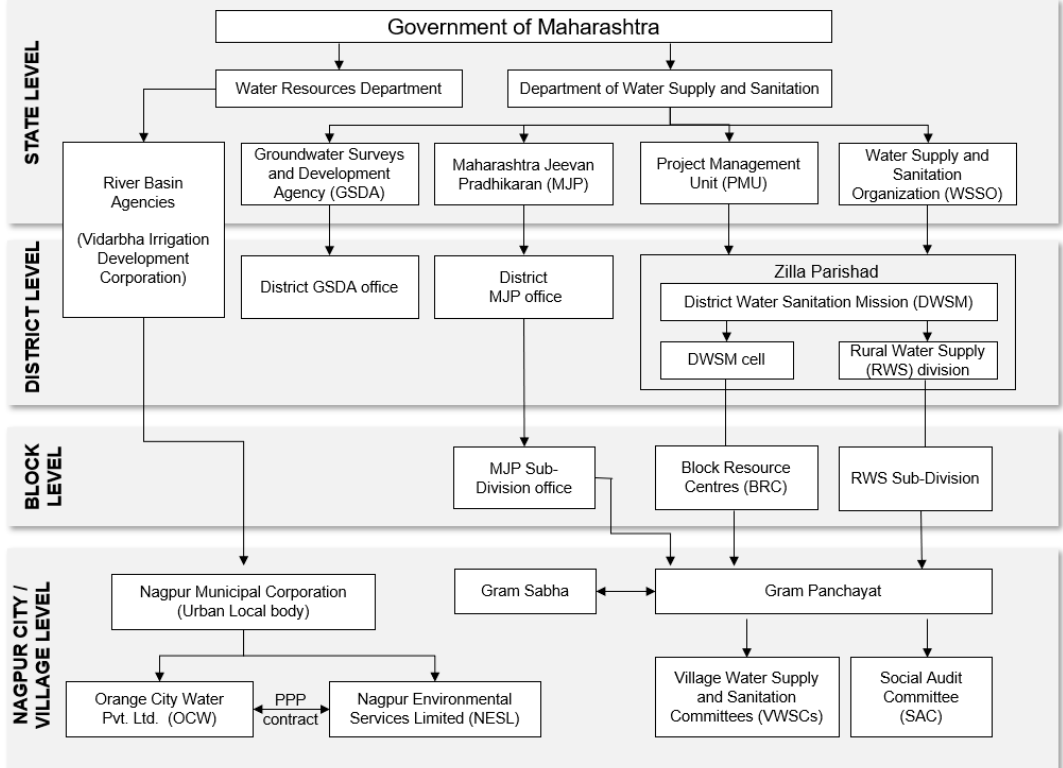
Figure 9. Institutional structure for water governance in Maharashtra State. Prepared by the authors, in reference to earlier studies [104,120]. The figure only provides a generalized understanding of water governance in Maharashtra. Additionally, there are several other agencies at different governance levels.